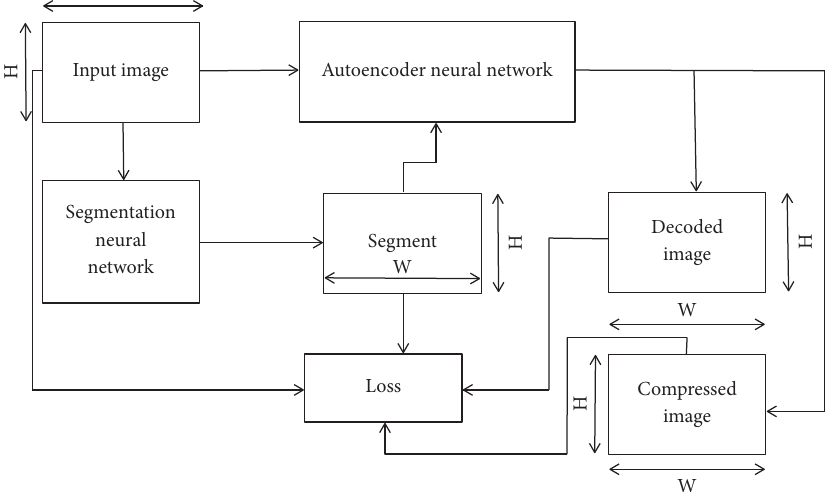
Figure 1: The main components in the proposed medical image compression